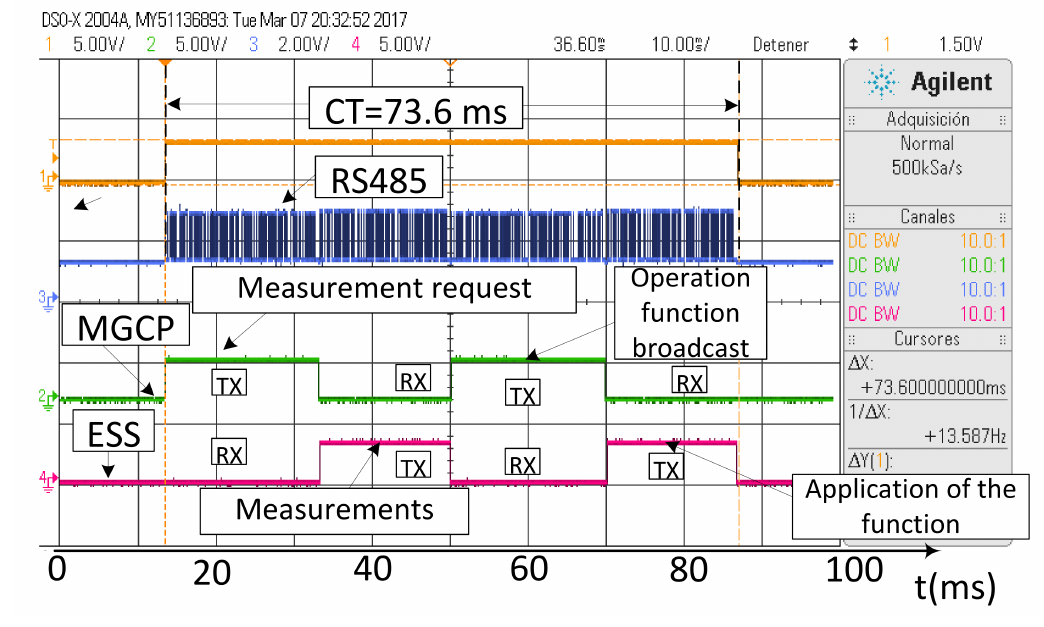
Figure 12. Experiment